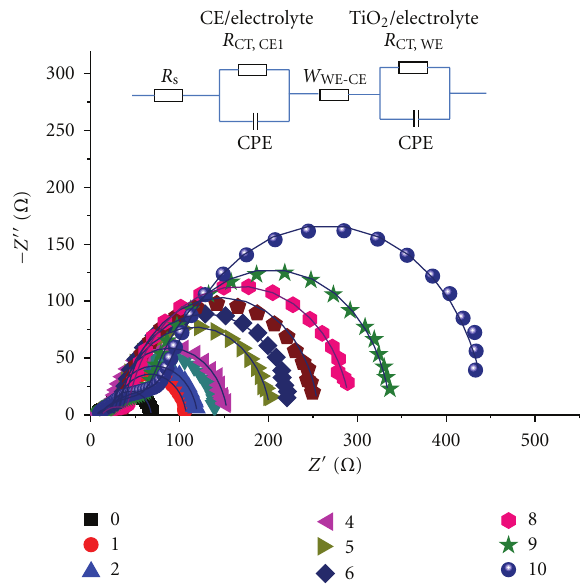
Figure 4: The Nyquist plots of the corresponding DSSCs under various electrolyte refreshing times in the dark at an applied forward bias of − 0.75 V. The dot is the experiment data and the line is the fitting data via the inset equivalent circuit.